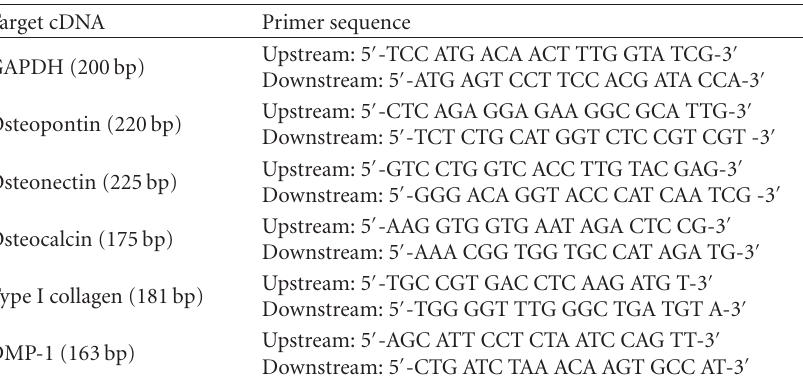
Table 1: Primer sequences for target cDNAs.